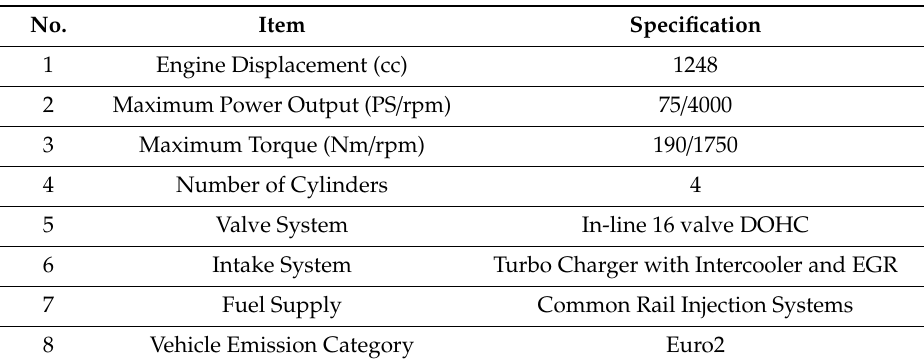
Table 2. Vehicle Specification.